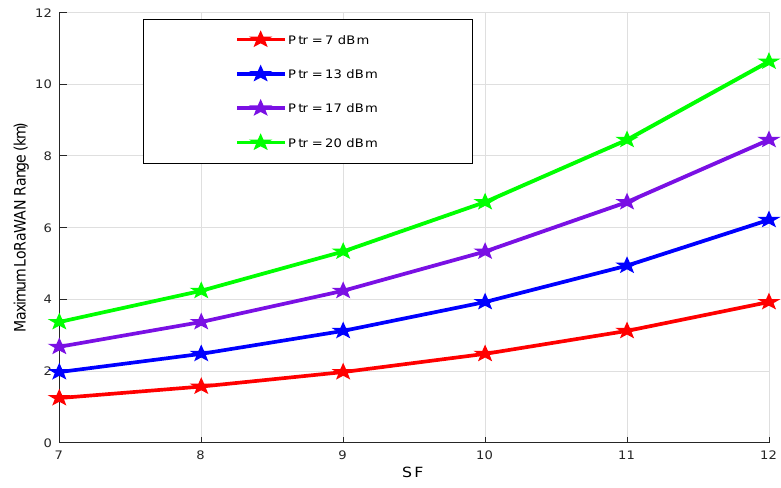
Figure 12. Maximum LoRaWAN range vs. SF .